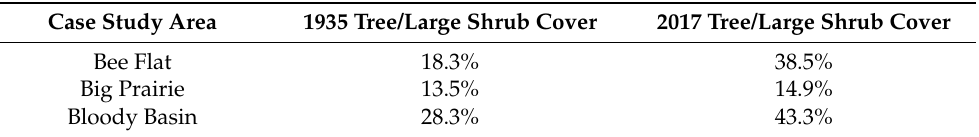
Table 1. Overall tree/large shrub canopy cover (percent cover estimates) derived from the binary canopy maps for each of the study areas. There appears to be a large increase in predominately woodland tree cover between 1935 and 2017 for at least two of the study